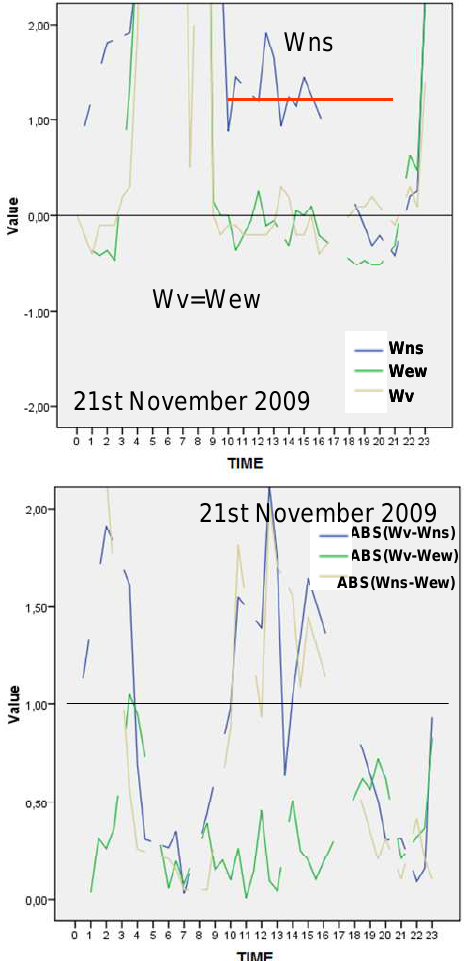
Fig. 11. South pattern: time-series plots on 21 November 2009. X axis (Time UTC). Y axis (Velocity in ms -1 ). Top panel, Vertical wind velocities. The red line indicates the positive deviation of Wns. Bottom panel, Absolute values of the differences between components of wind velocities.